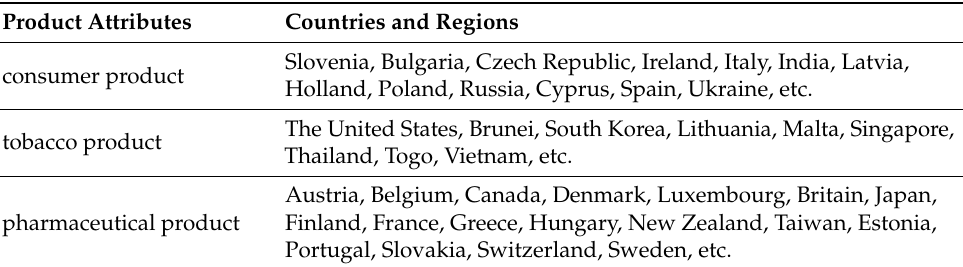
Table 1. Classification of E-cigarettes in different countries